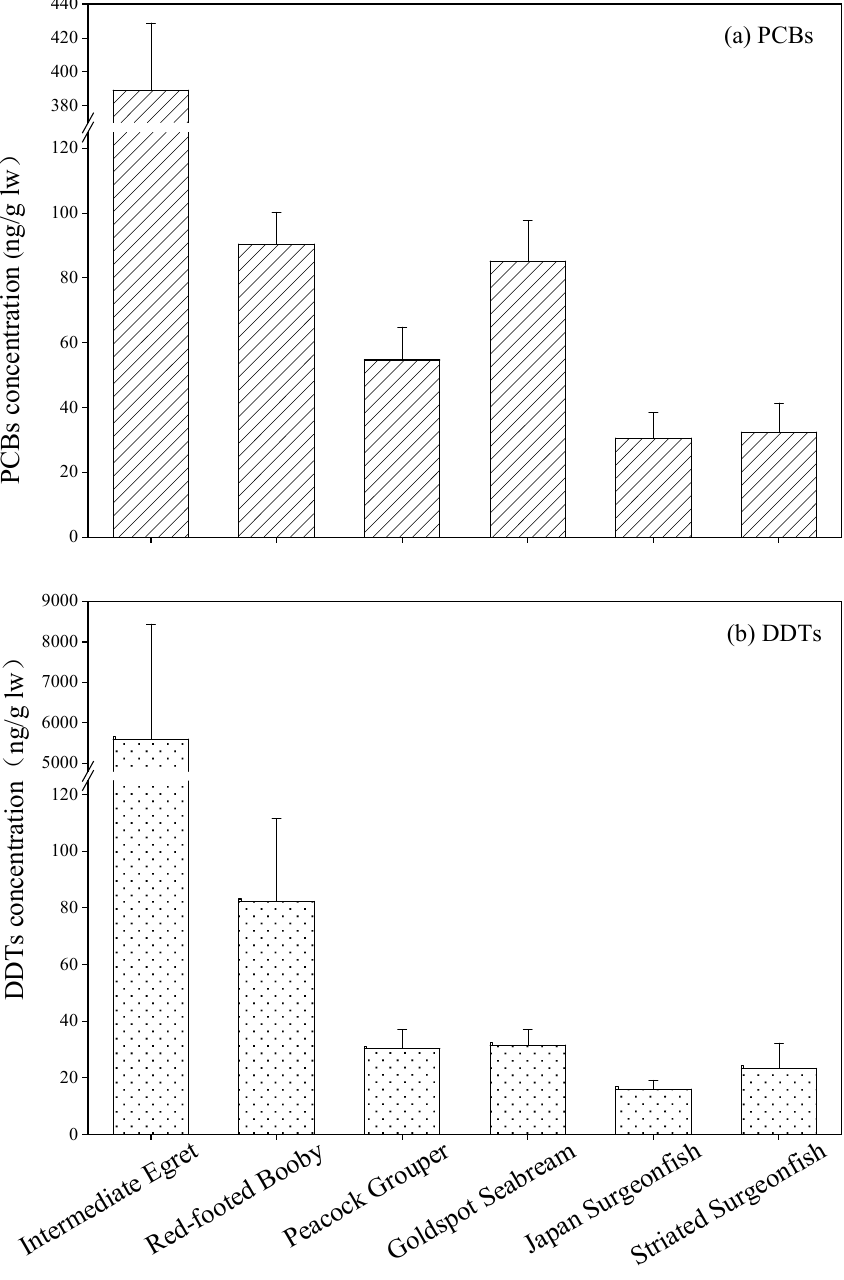
Figure 2. Concentrations of PCBs and DDTs (mean ± standard error) in biota from Qilianyu Island.